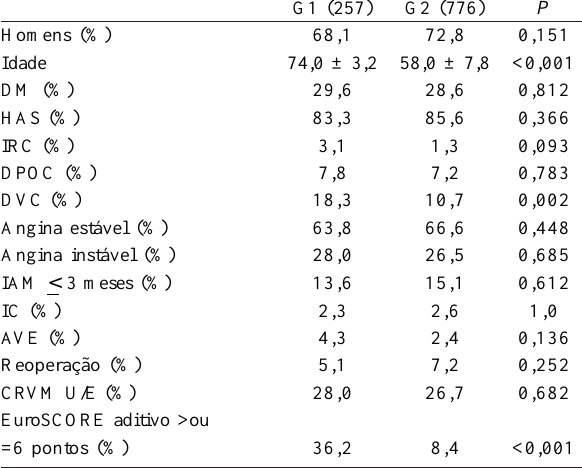
Tabela 3. Resultados pós-operatórios nos dois grupos de pacientes Letalidade hospitalar(%)